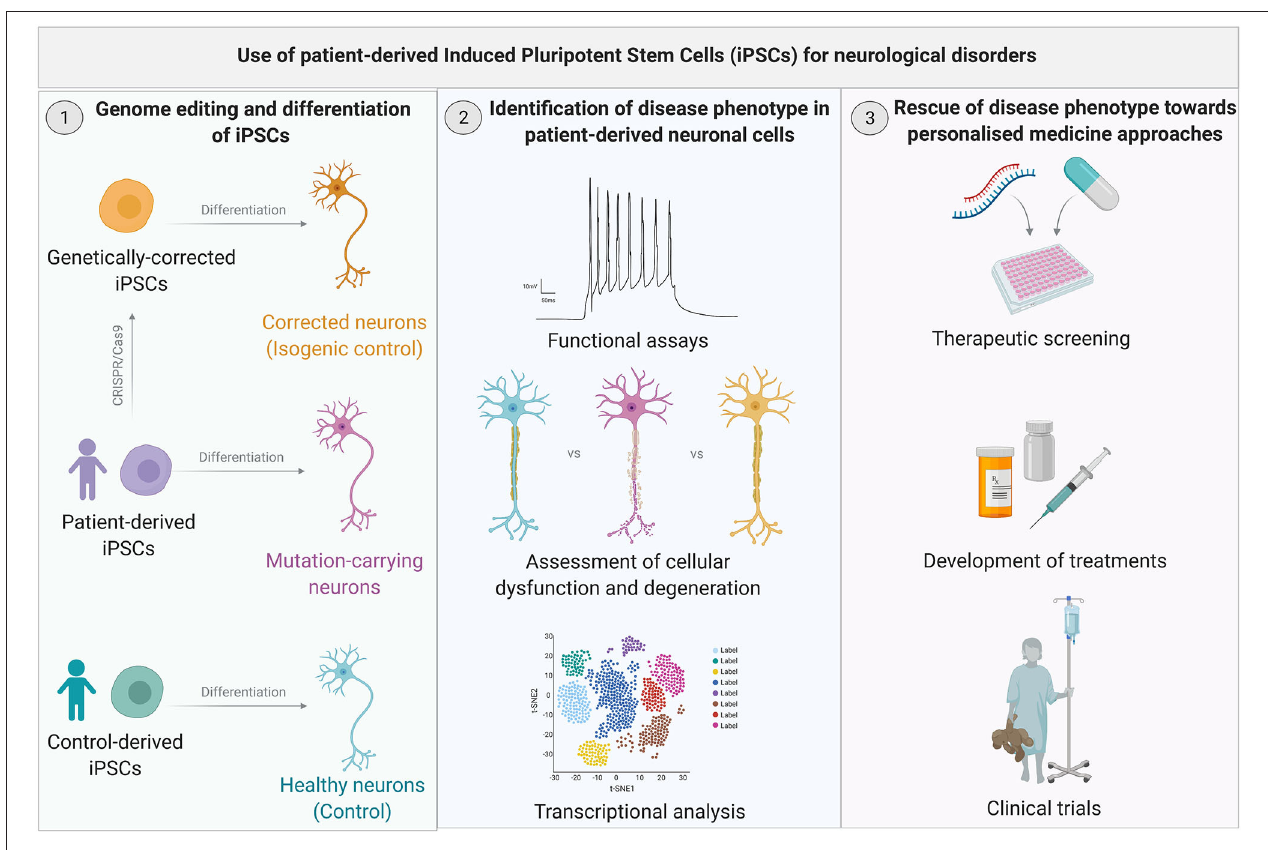
FIGURE 1 | Use of patient-derived Induced Pluripotent Stem Cells (iPSC) for neurological disorders. (Left) iPSCs are readily derived from patients and controls through cellular reprogramming. Patient- and control-derived iPSCs are differentiated into the neuronal type relevant to the specific disease. Gene editing techniques such as CRISPR-Cas9 can be utilized to genetically correct the mutation in iPSCs to obtain isogenic control lines which only differ from the mutated iPSC lines by the genetic variant of interest. (Middle) Following genome editing and differentiation of iPSCs, derived cells are used to gain phenotypic insights into the specific disease mechanism through a variety of functional, morphological, and molecular analysis. (Right) Once a disease phenotype has been identified, iPSC-derived neuronal cells can be utilized for drug screens, which could accelerate personalized therapies for neurological